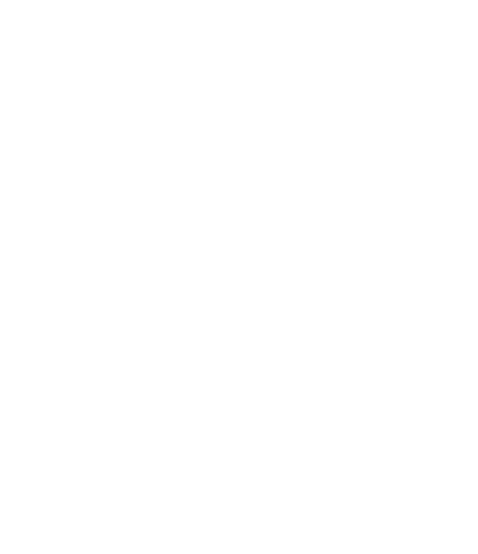
Table 1. Variants of WCS-EPF for constant